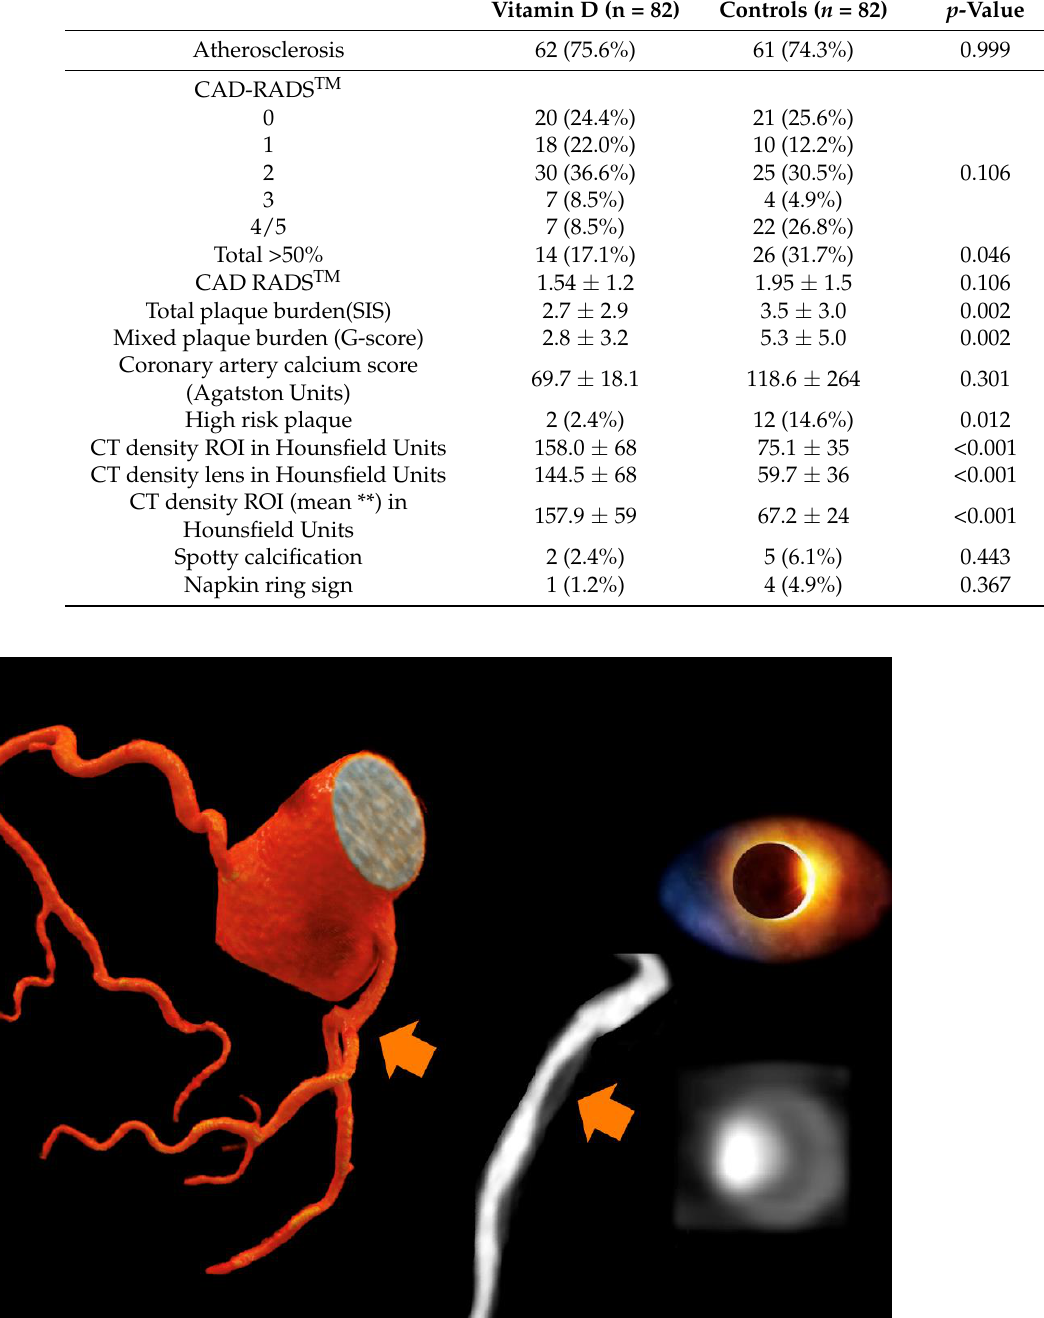
Table 2. Coronary artery disease profile assessed by computed tomography angiography. Parametric data are shown as means ± SD, ordinal data as counts (n) and percentage (%). ** mean of 3 slices. Vitamin D (n = 82)